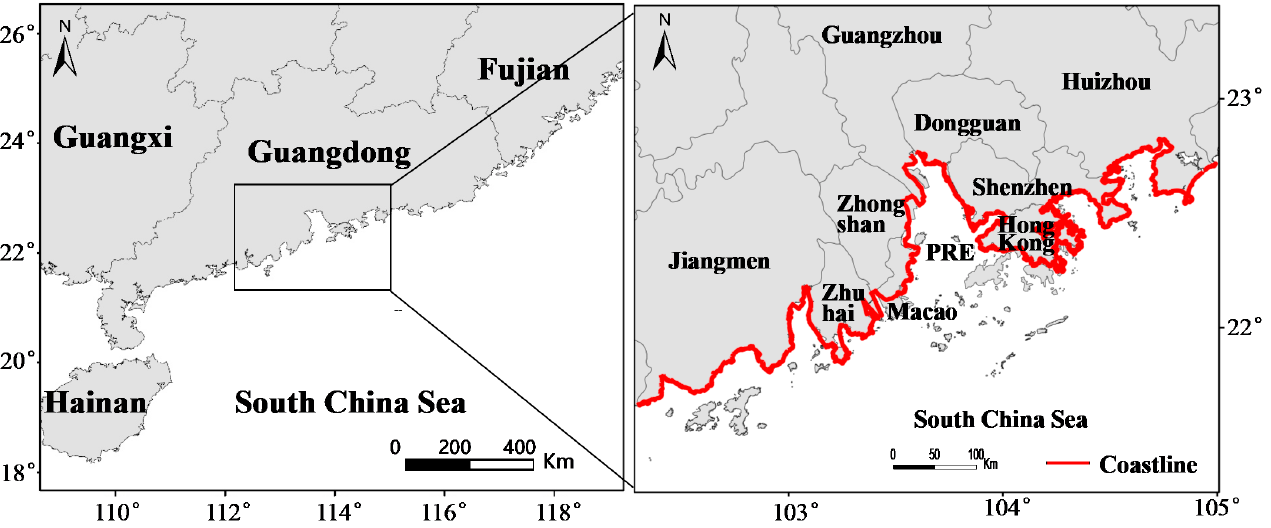
Figure 1. Study area.